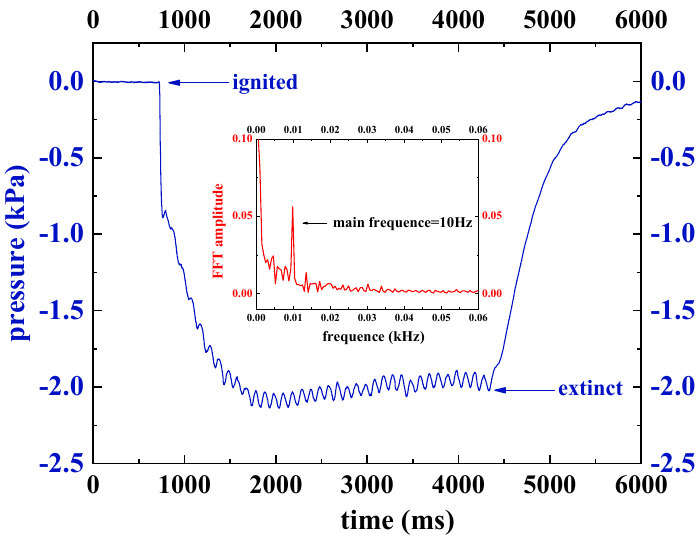
. = 120 SLM . V air ) pulsating V SLM =  . air pulsating